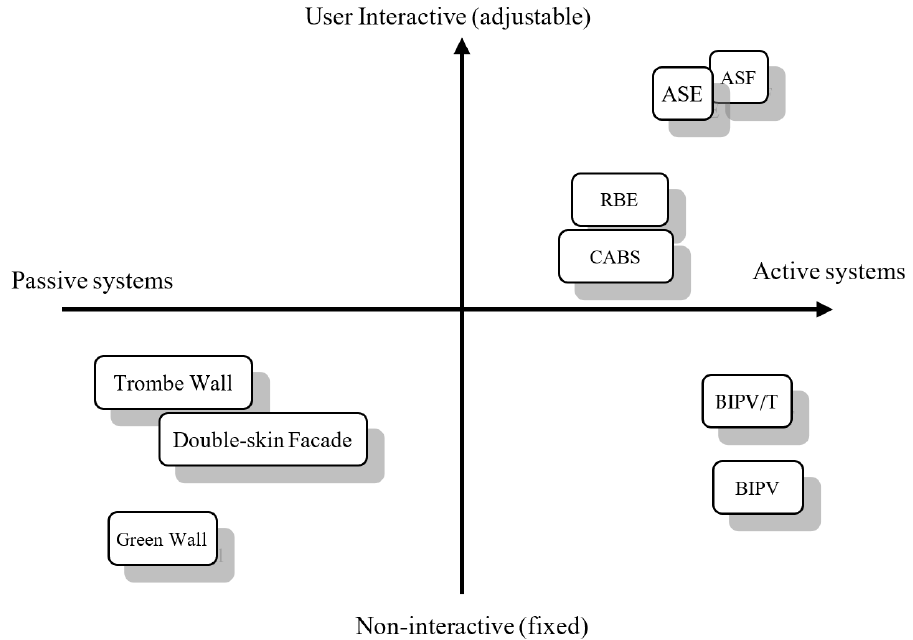
Figure 2. Distribution of ADBE systems using active and passive systems.